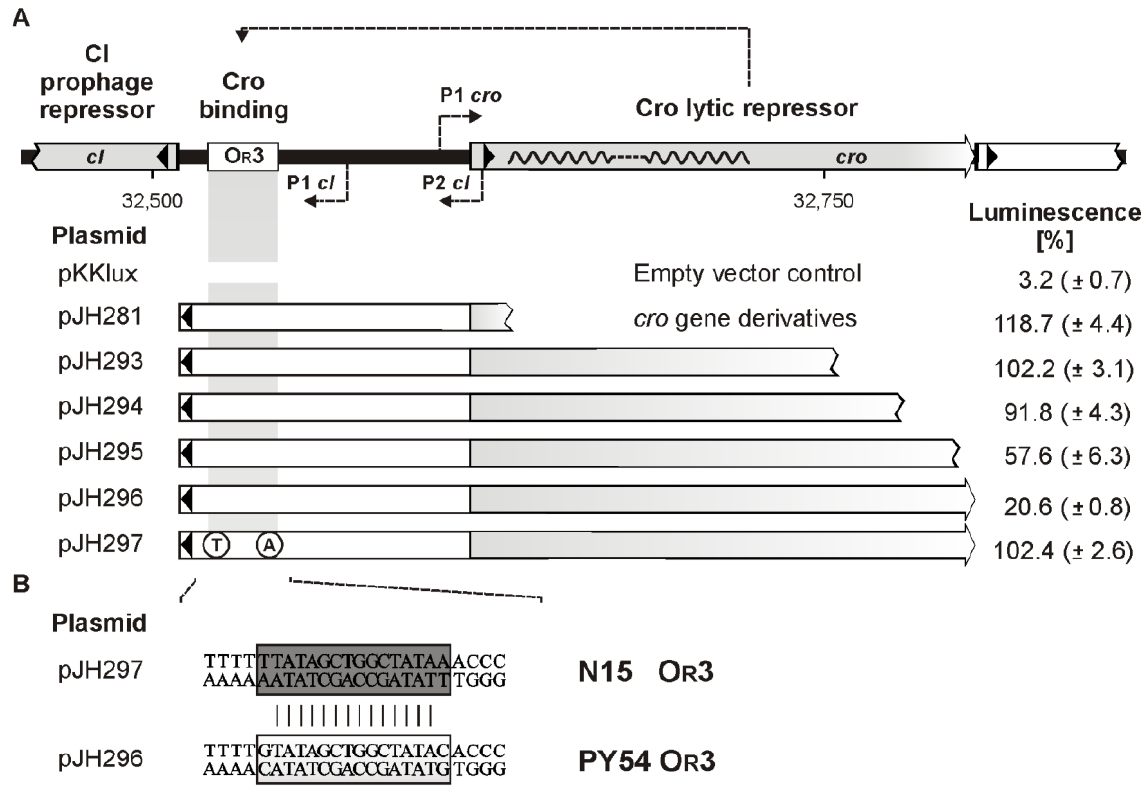
Figure 7. Repression of PY54 cI transcription by Cro binding to O R 3. ( A ) At the top, the repressor genes, the O R 3 operator site and the identified cI and cro promoters within the intergenic region of PY54, are shown. Constructs tested for bioluminescence activity are listed below. Black arrowheads indicate the direction (towards cI ) in which the fragments were inserted into the promoter search vector pKKlux. Spontaneous mutants exhibiting base pair exchanges within O R 3 are also presented. On the right, transcription activities of the constructs compared to those of the naked vector pKKlux and plasmid pKKL700 (ST-LS1 promoter = 100 %) are given. Standard deviations are shown in brackets; ( B ) Alignment of the PY54 and N15 O R 3 operator sequences.